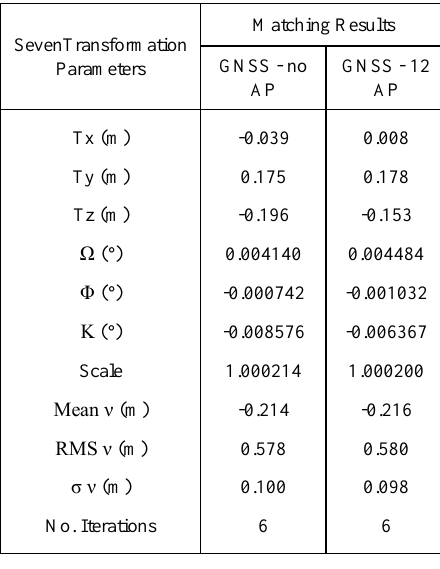
Table 1: Transformation parameters determined with and without self-calibration.